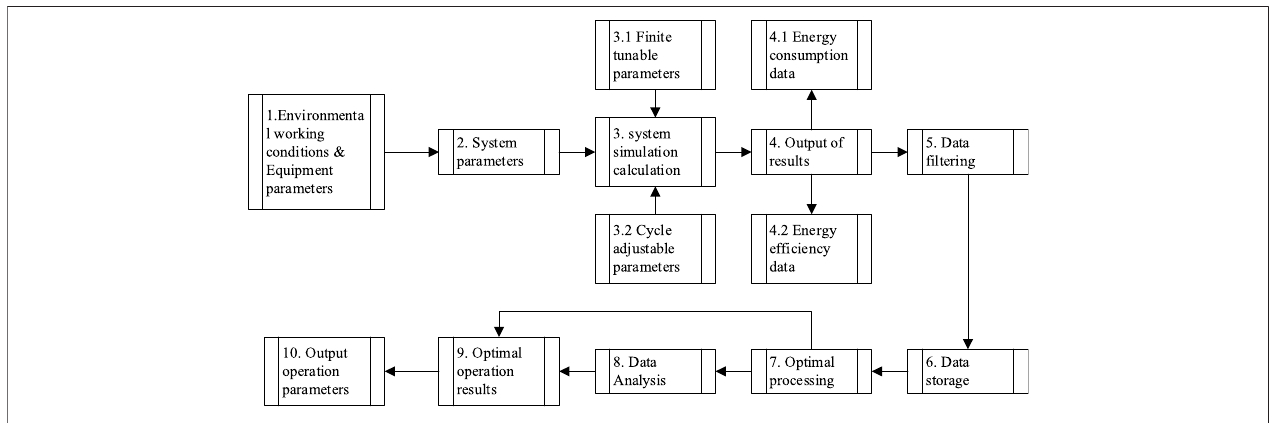
FIGURE 3 | Simulation calculation fl ow